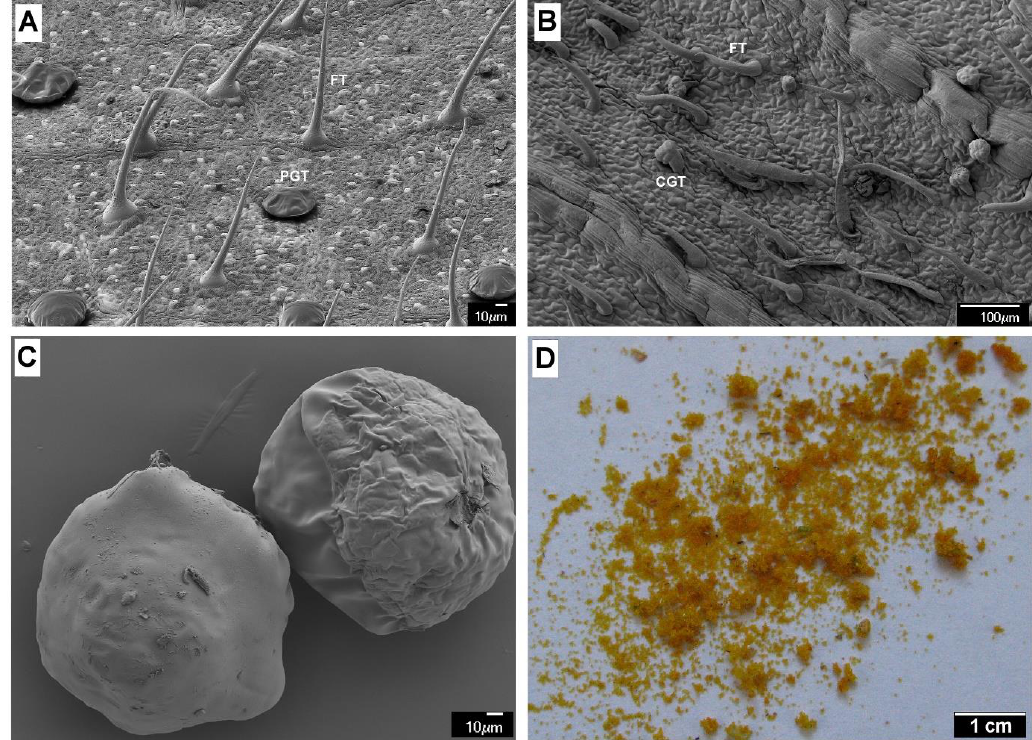
Figure 1. Scanning electron micrograph showing the distribution of different type of trichomes (FT: fibrous trichomes; PGT: peltate glandular trichomes; CGT: capitate glandular trichomes) on the surface of leaf ( A ), bracteole blade ( B ). The scanning electron ( C ) and light microscopy ( D ) image of ripe lupulin glands.